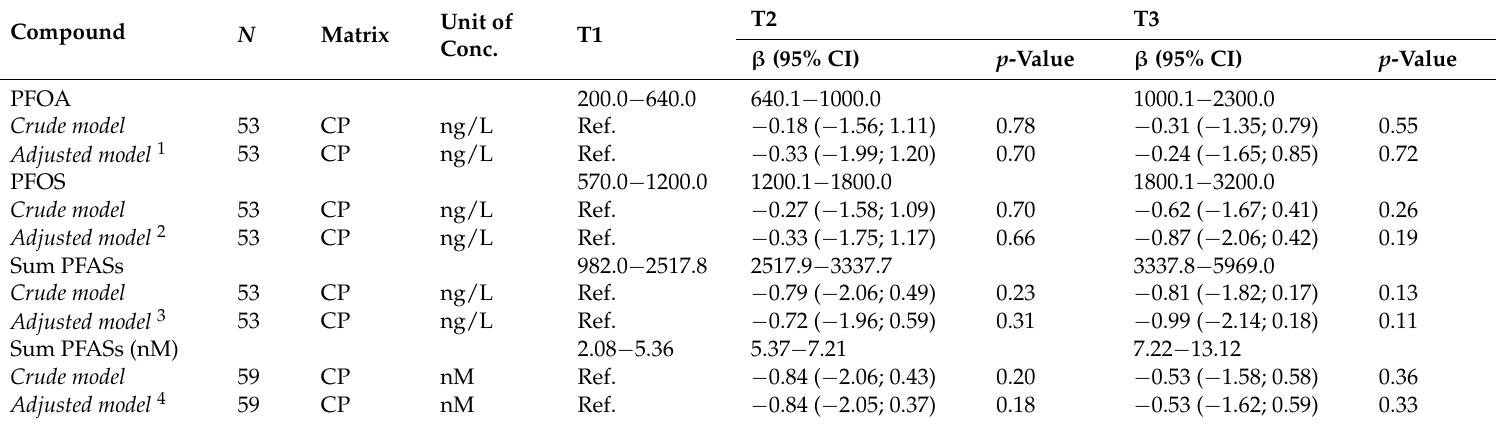
Table A1. Regression coefficients for exposure to perfluoroalkyl substances and scores on the Attention Deficit Hyperactivity Disorder scale of the CBCL, for the whole